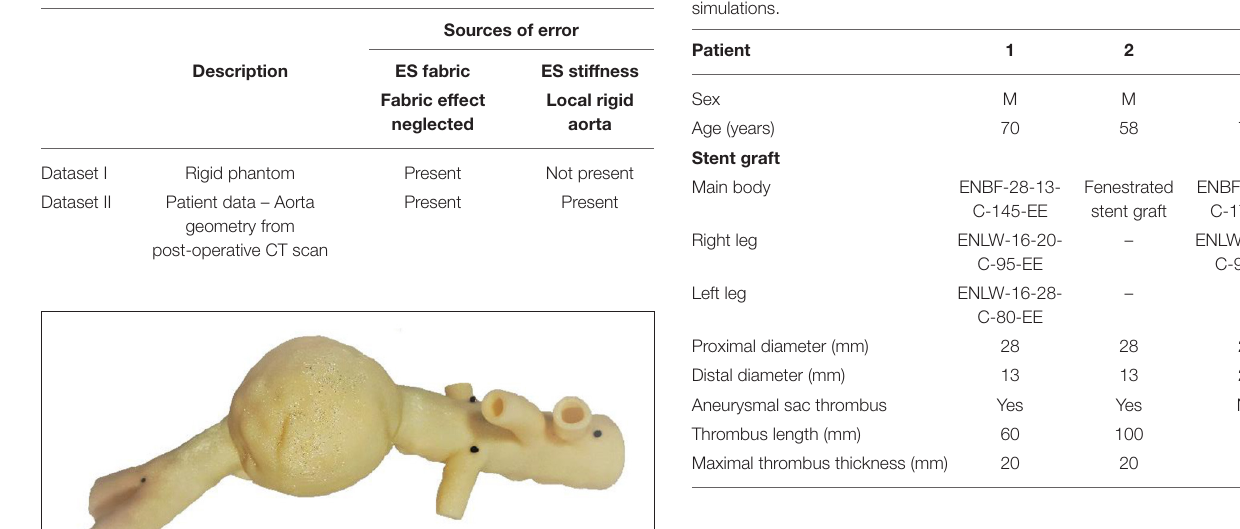
TABLE 1 | Sources of error in each Dataset.